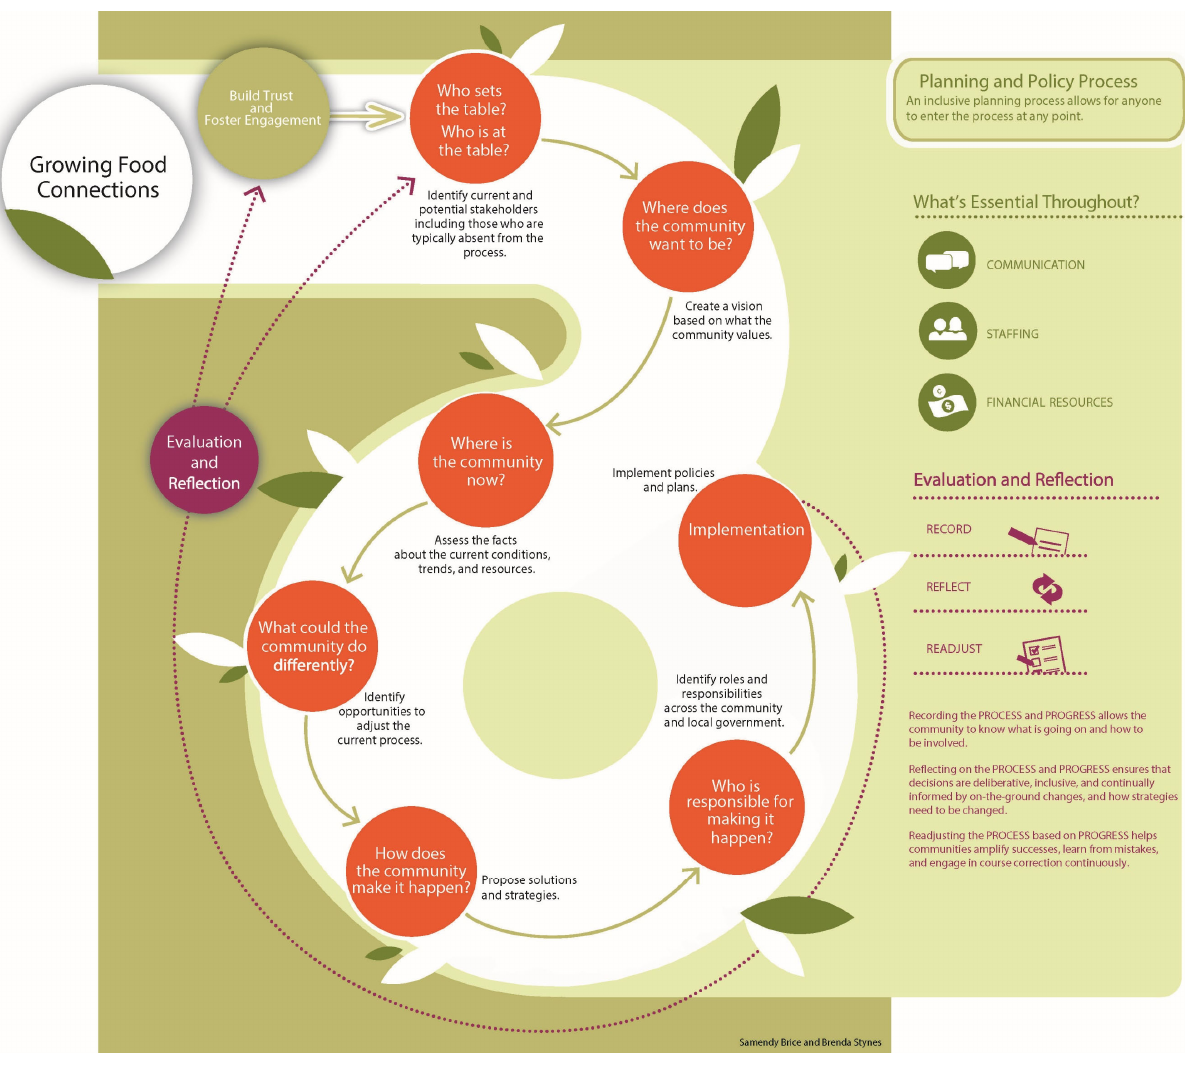
Figure 1. Inclusive Planning and Policy Processes for Strengthening Community Food